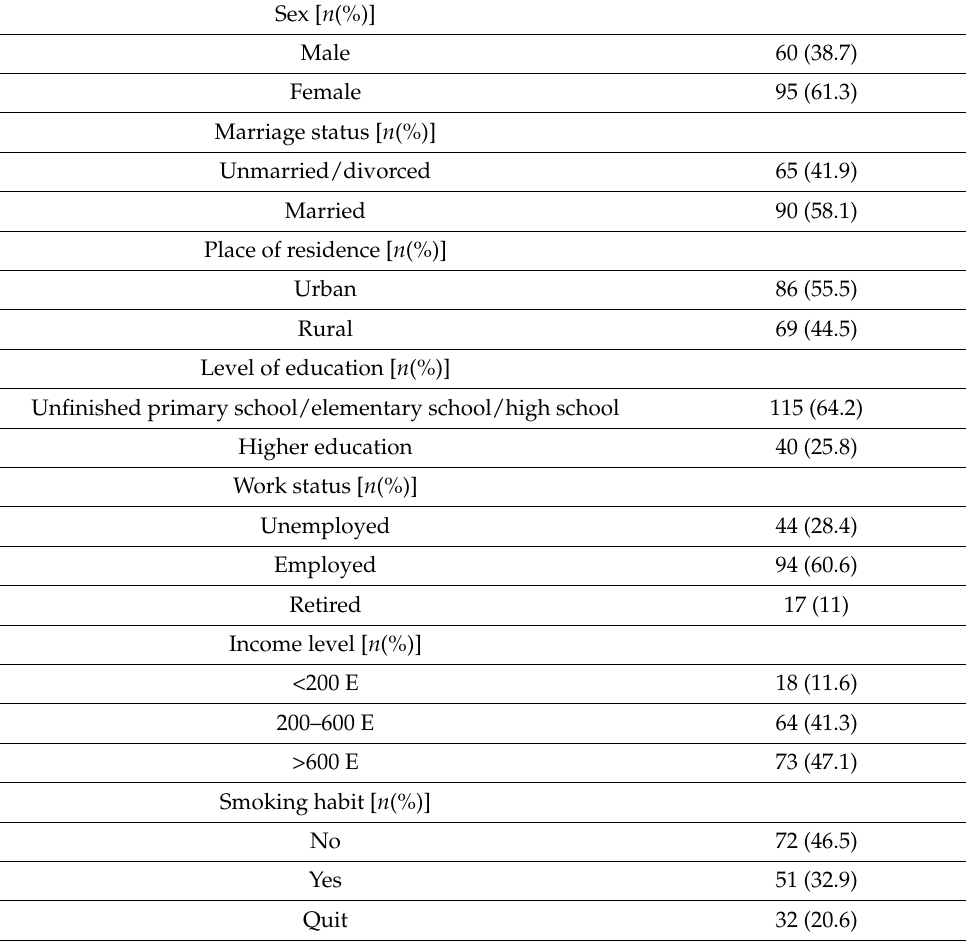
Table 1. Baseline characteristics of subjects participating in the